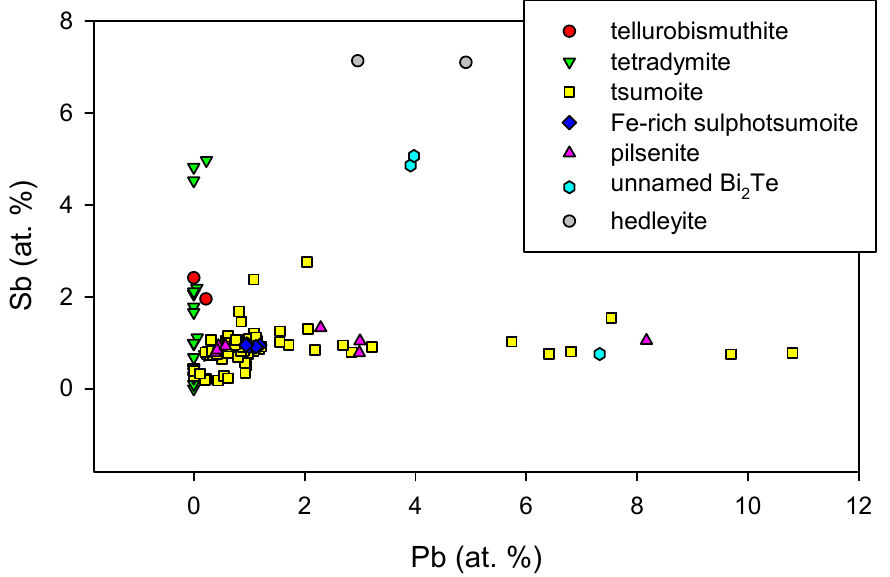
Figure 11. The Pb and Sb contents (at. %) in Bi-(sulpho)tellurides.